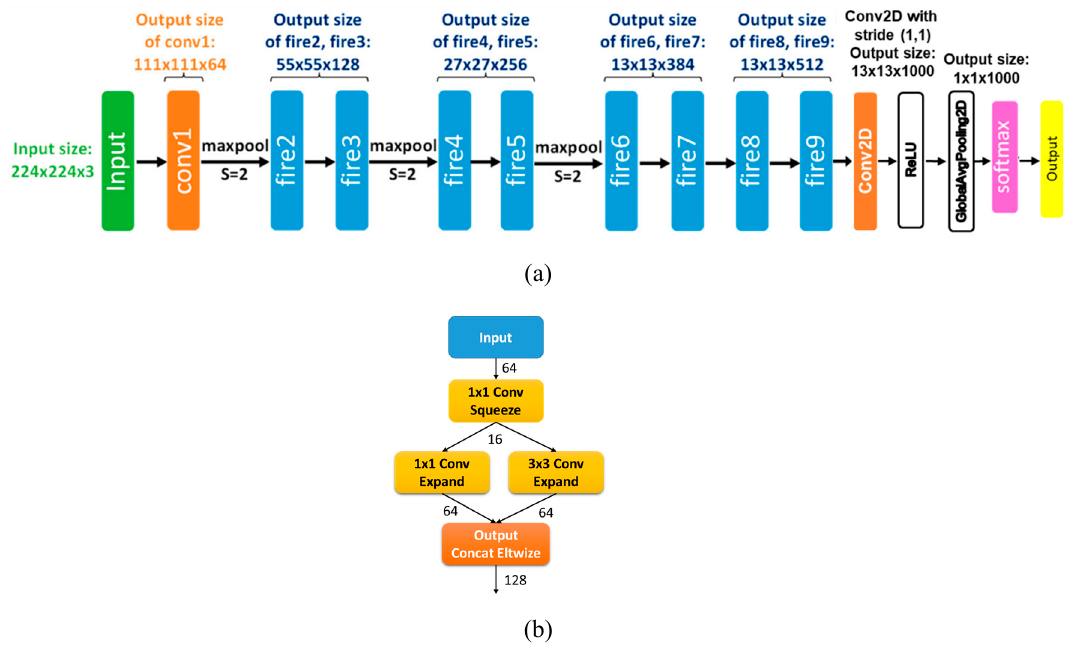
Figure 4. Overview of the SqueezeNet architecture. ( a ) Overall architecture; ( b ) the fire module with squeeze and expand layers.